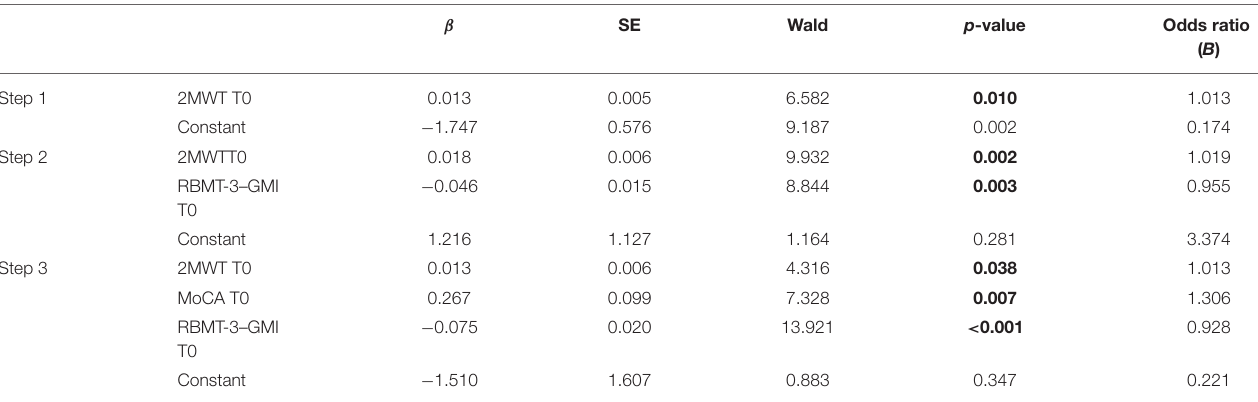
TABLE 6 | Binary logistic regression model to test best predictors of the RBMT-3–GMI change after rehabilitation.